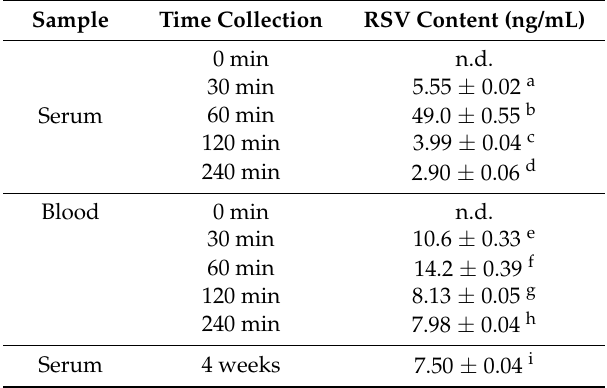
Table 2. Pharmacokinetic profile of Taurisolo ® .